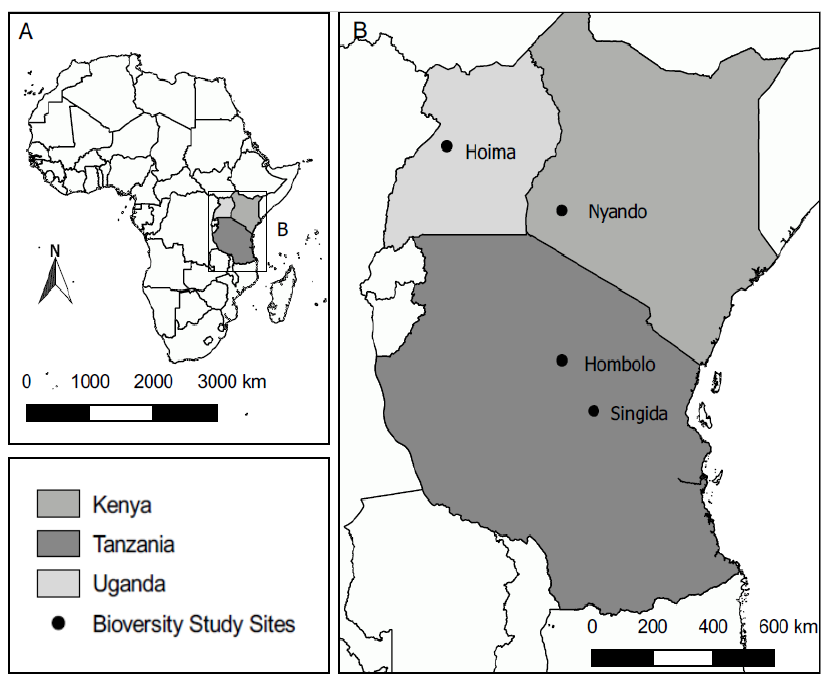
Figure 1. Study Communities in Kenya, Tanzania, and